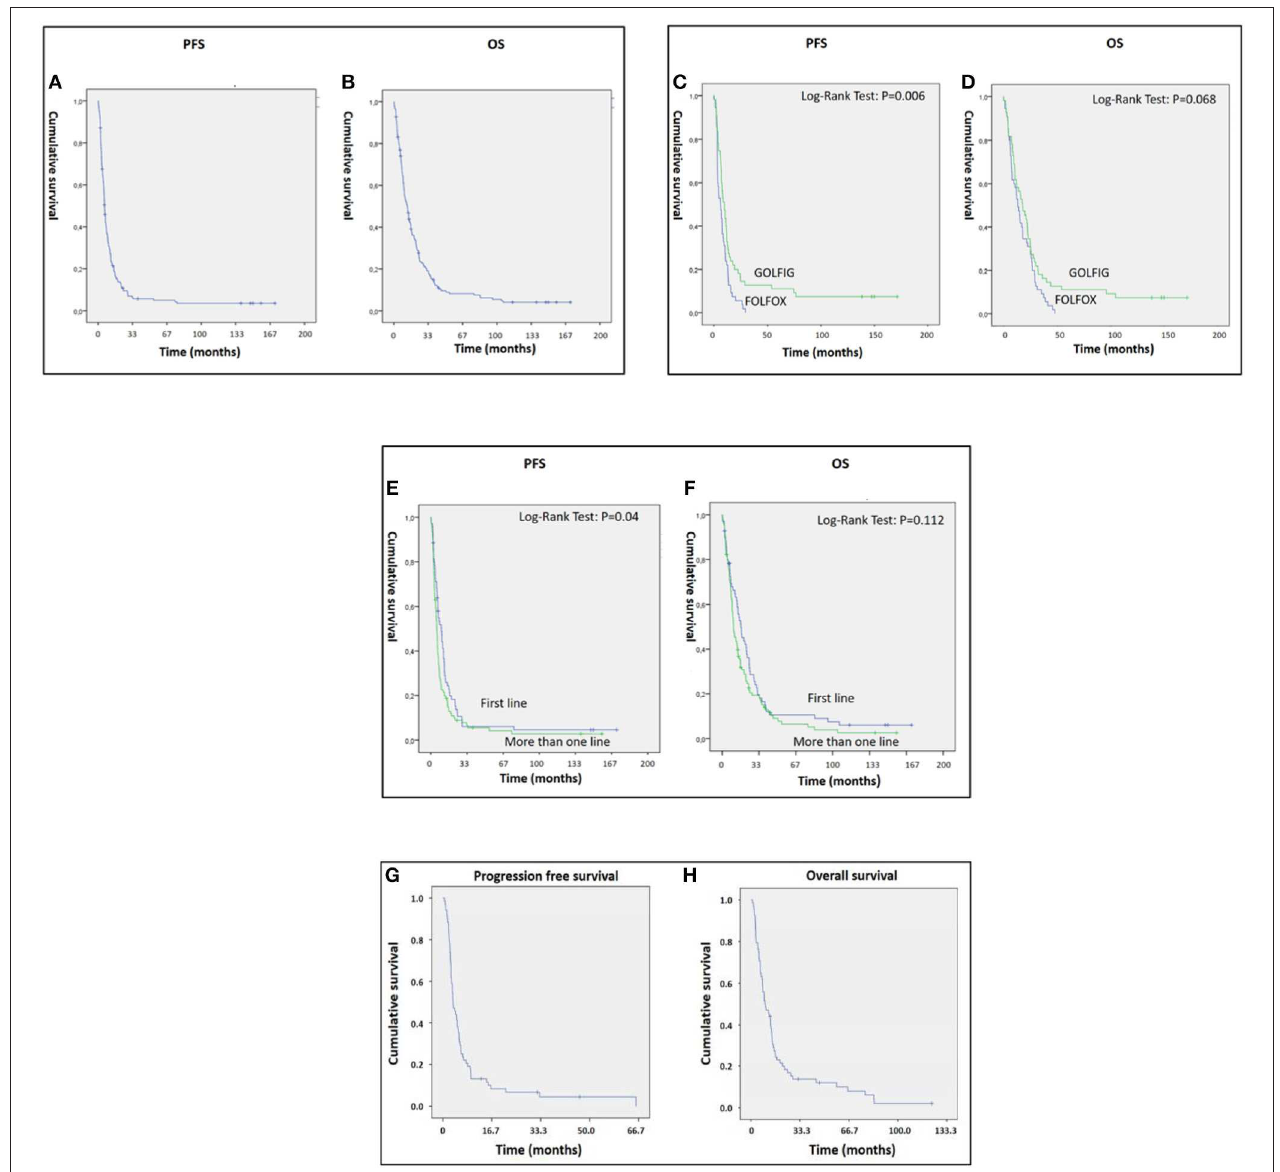
FIGURE 1 | (A–H) Panels A and B represent PFS (A) and OS (B) of metastatic colorectal cancer (mCRC) patients who received the GOLFIG (gemcitabine, oxaliplatin, LF, and fluorouracil poly-chemotherapy with granulocyte-macrophage colony stimulating factor and interleukin-2) regimen and enrolled in the GOLFIG-1